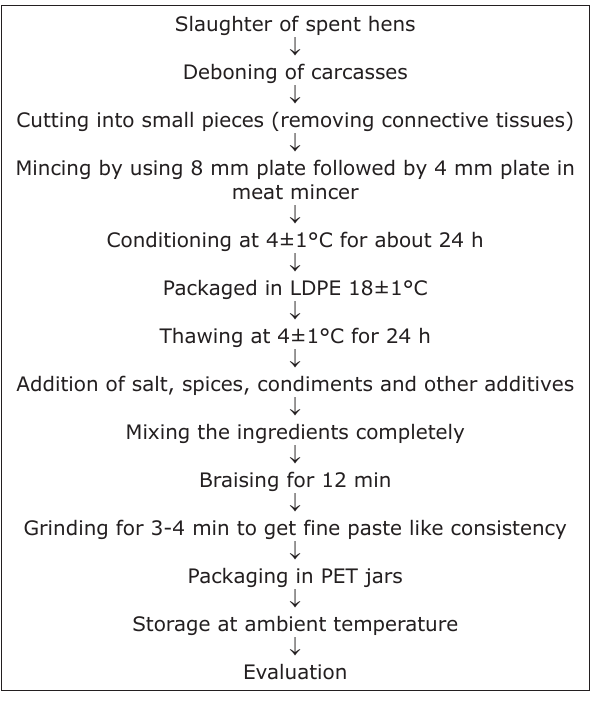
Figure-1: Processing protocol for the development of meat